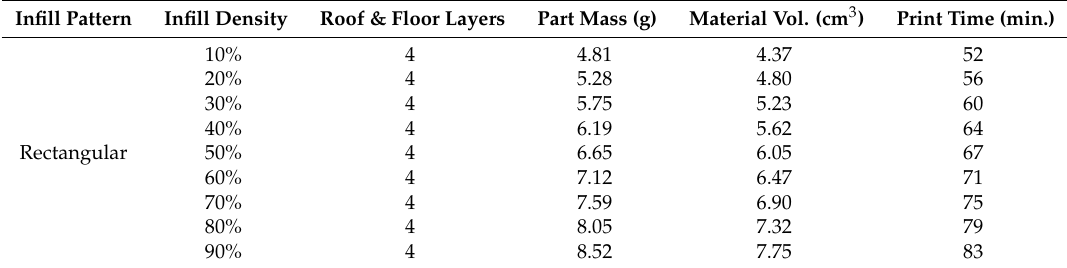
Figure 1. Extrusion AM substrates: ( a ) Rectangular infill pattern. ( b ) Hexagonal infill pattern. ( c ) Triangular infill pattern. Table 1. Nylon substrates information from Eiger for Research Question 1.